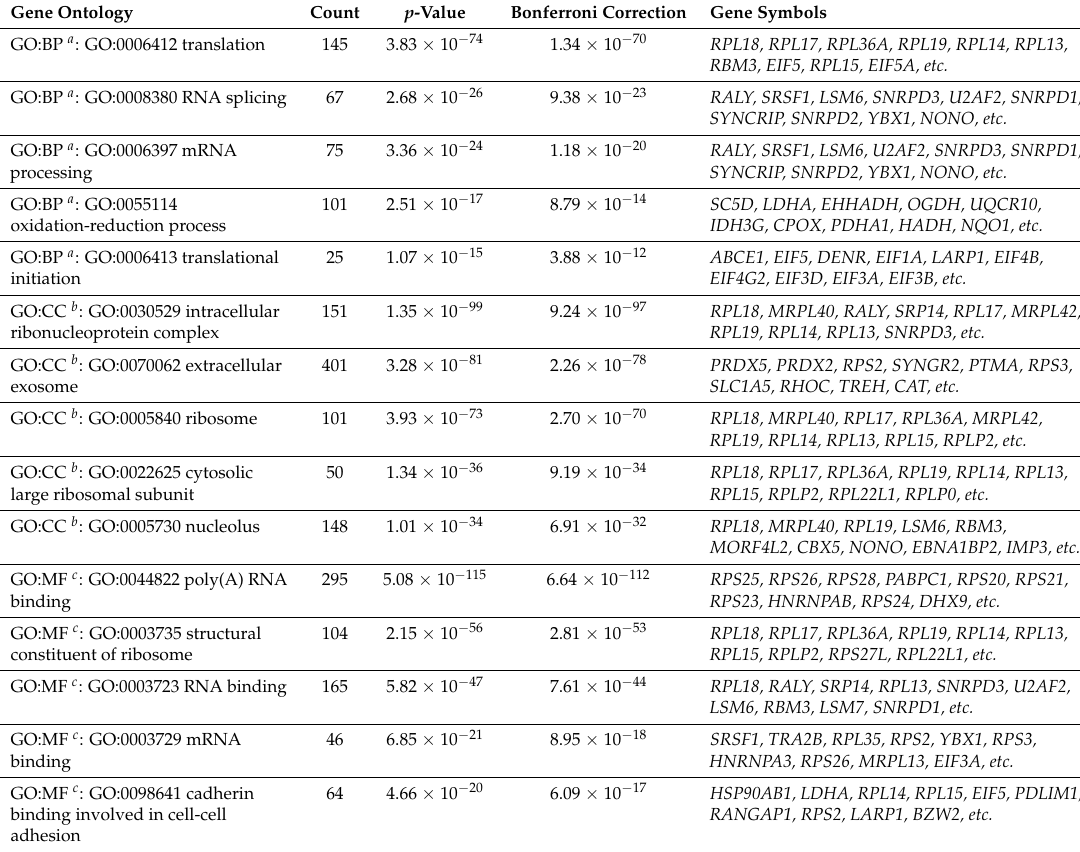
Table 5. Top five Gene Ontology (GO) terms in each GO domain enriched in differentially expressed